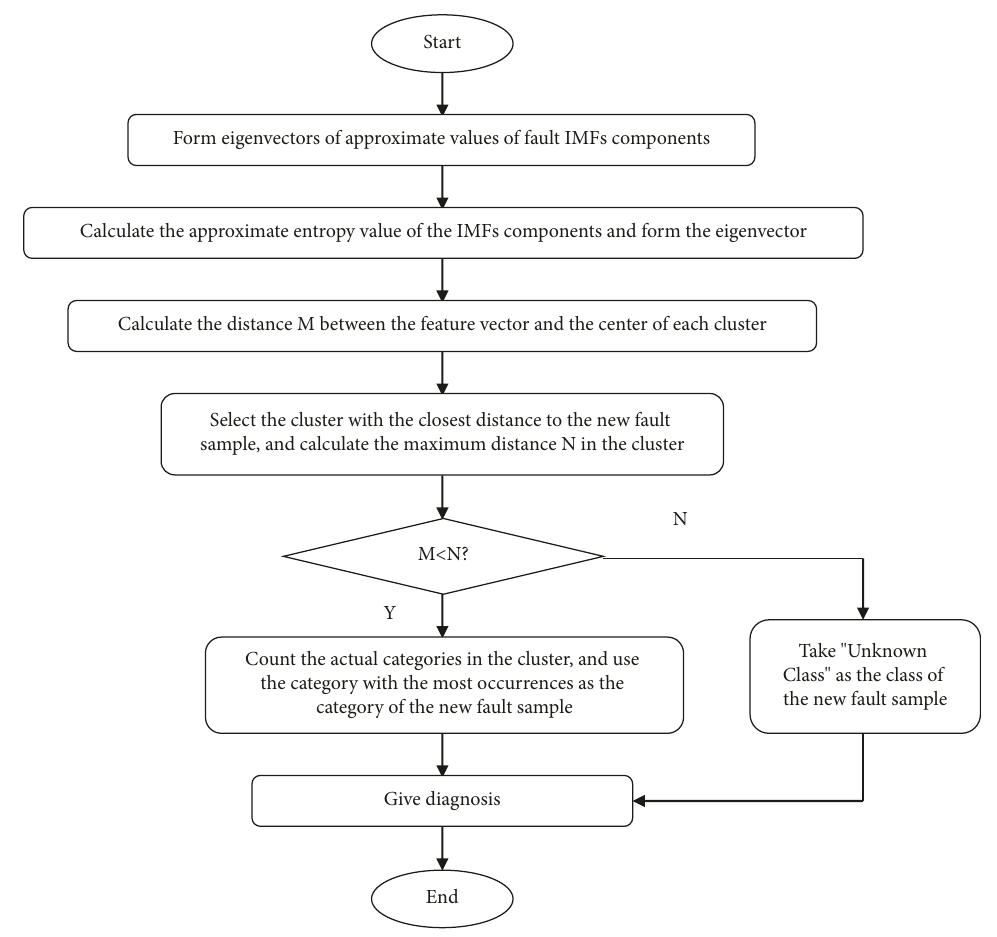
Figure 3: Fault diagnosis process.